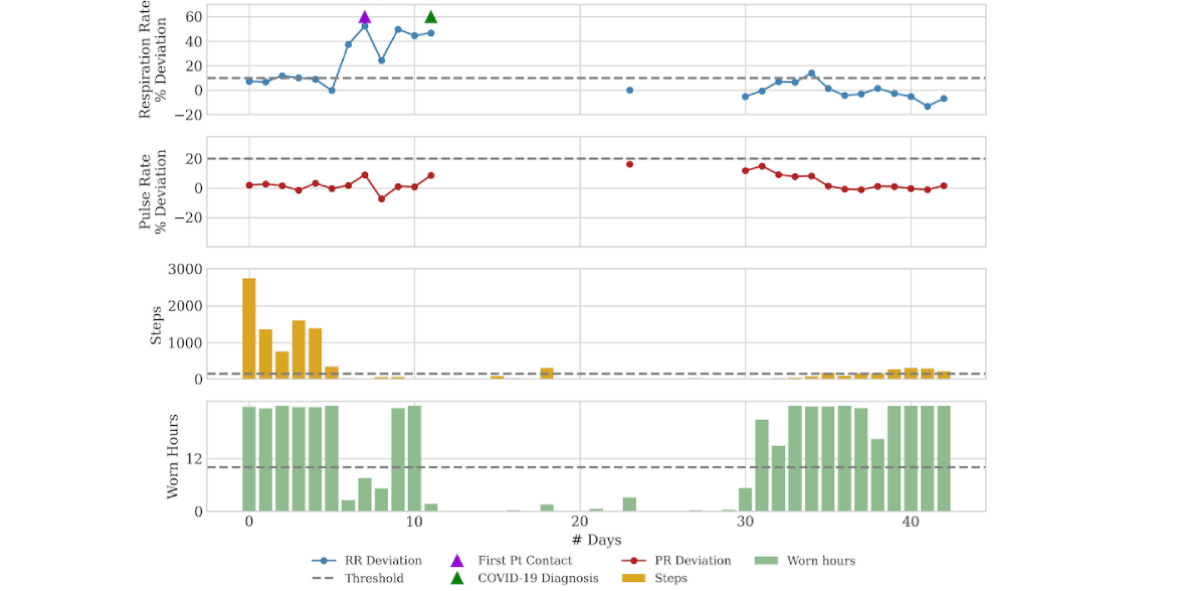
Figure 1. Daily physiology, activity, and adherence metrics for Case 1. The patient was hospitalized for COVID-19–related symptoms 5 days after she was contacted by the respiratory therapist call center. Physiology shows return to baseline after discharge 17 days later. Each point for RR and PR represents the percent difference between that day’s median value and that patient’s lifetime median baseline value. The thresholds are clinician-configurable points at which notifications are triggered. Default threshold values (for all three cases): worn hours <11 hours, RR % deviation: >10, PR % deviation: >20, and steps: <150. PR: pulse rate; Pt: patient; RR: respiratory rate.